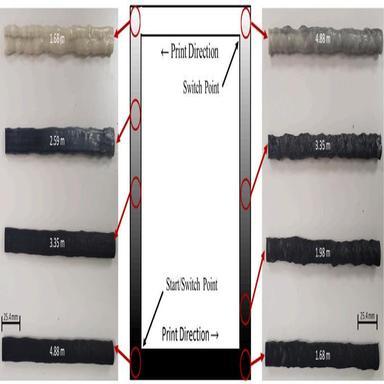
Depiction of sampling locations for the process repeatability portion of the study. The number in the center of each rod measures the distance from hopper switch.